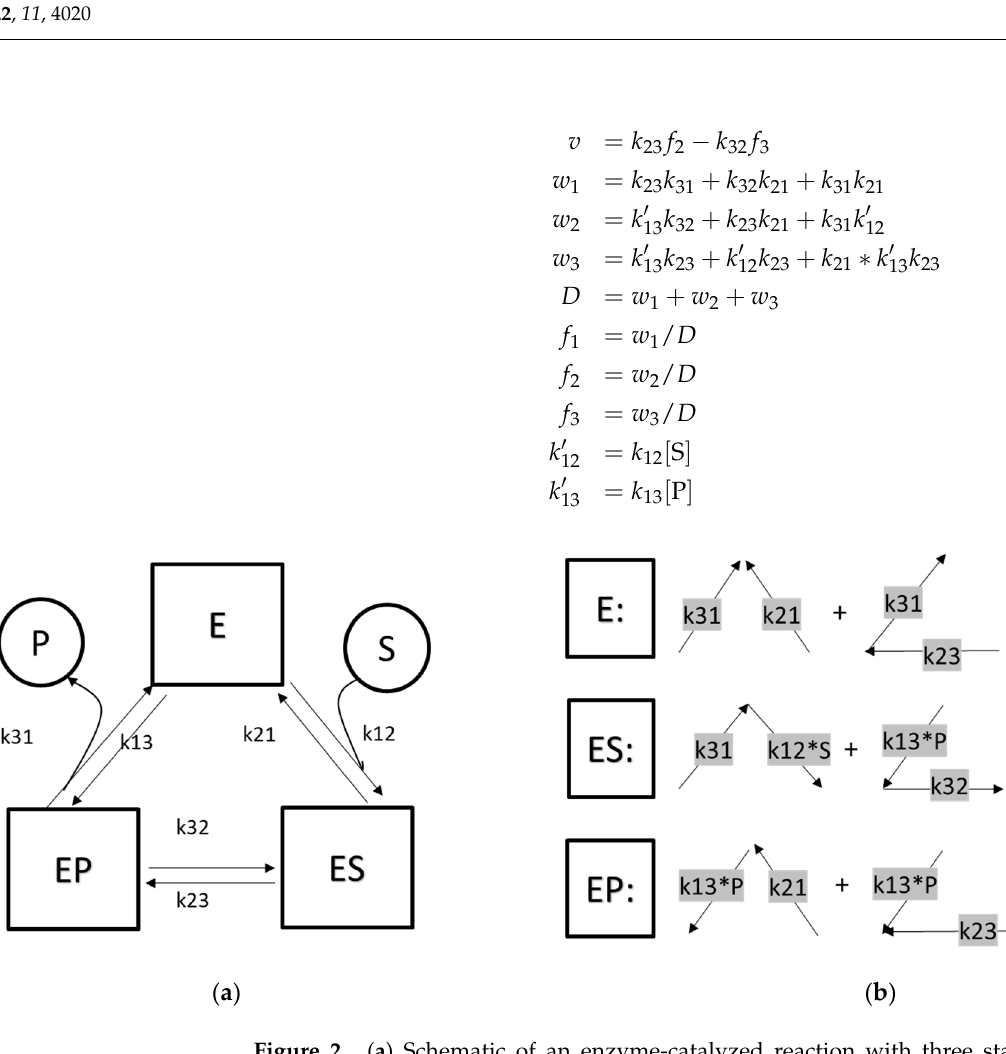
Figure 2. ( a ) Schematic of an enzyme-catalyzed reaction with three stages: the free enzyme (E, stage 1), the substrate-bound form (ES, stage 2), and the product-bound form (EP, stage 3). kij are rate constants transitioning from stage i to stage j. ( b ) The weight of each stage is the sum of the products of the transitional rates in the three connected graphs: Λ , <, and >.